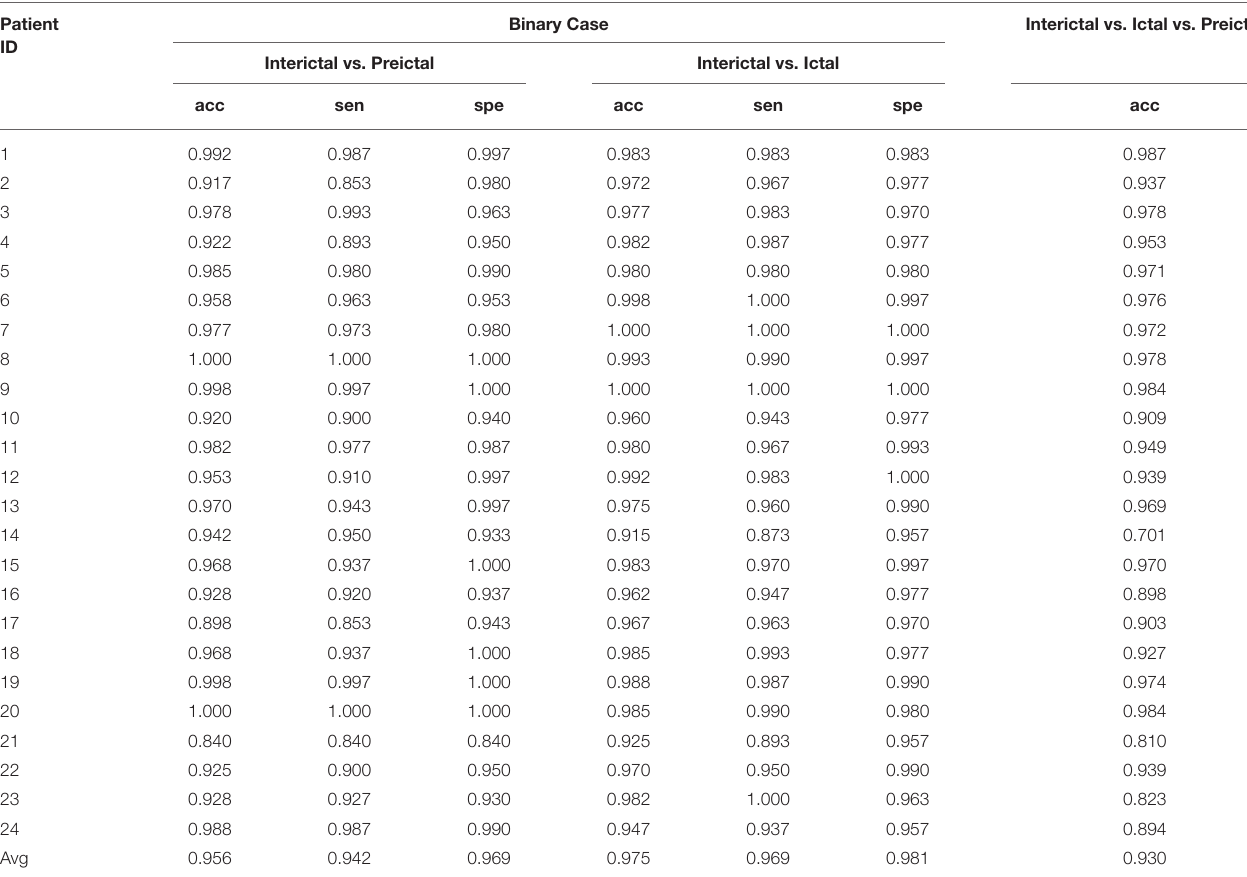
TABLE 3 | Frequency domain signal results for all patients in the CHB-MIT database. Patient